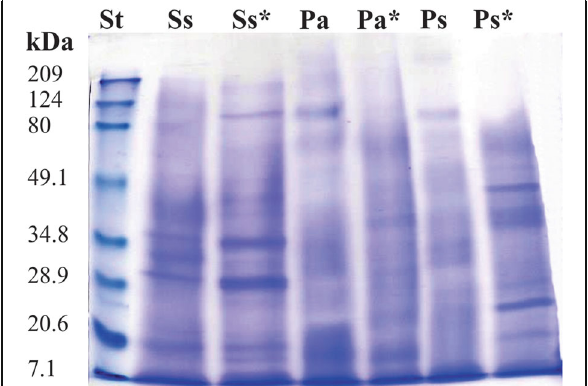
Table 4 Enzymatic activity of the aqueous extracts PLA 2 activity Serine protease Hyaluronidase ( μ mol/min/mg) activity (U/mg) activity (TRU/mg) Fig. 5 SDS-PAGE gel (12% acrylamide) showing an overview of the protein profiles of S. siderea (Ss), P. astreoides (Pa), and P. strigosa (Ps) extracts under native conditions. Ss*, Pa*, and Ps* correspond to the extracts under reducing conditions. The protein profiles were compared with a broad-range polypeptide standard (St). Protein bands were visualized with Coomassie brilliant blue staining